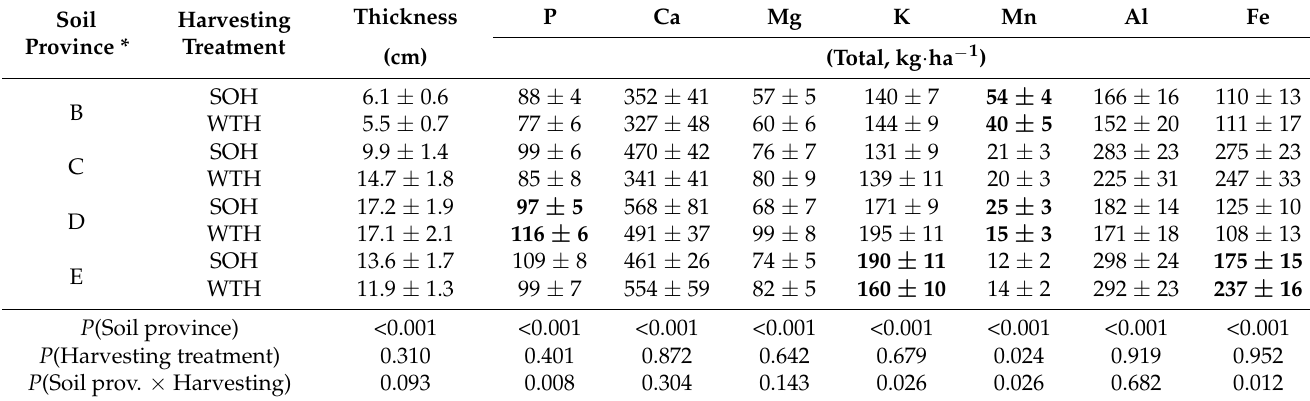
Table 4. Effect of harvesting treatment (SOH: stem-only harvesting, WTH: whole-tree harvesting) on thickness and total element pools in the forest floor, by soil province. Values are model-adjusted means ± standard errors. Values in bold indicate a significant difference ( p ≤ 0.05) between harvesting treatments within a given soil province.